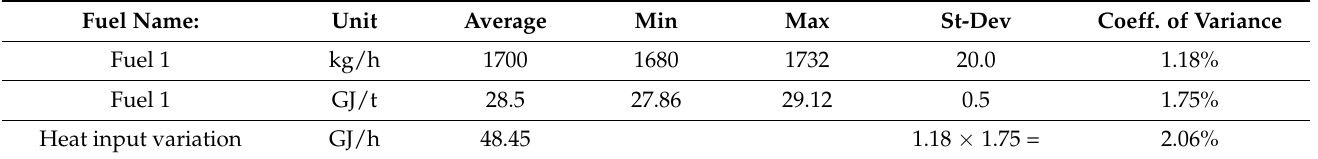
Table 3. Heat input variation calculation for one-fuel feed.